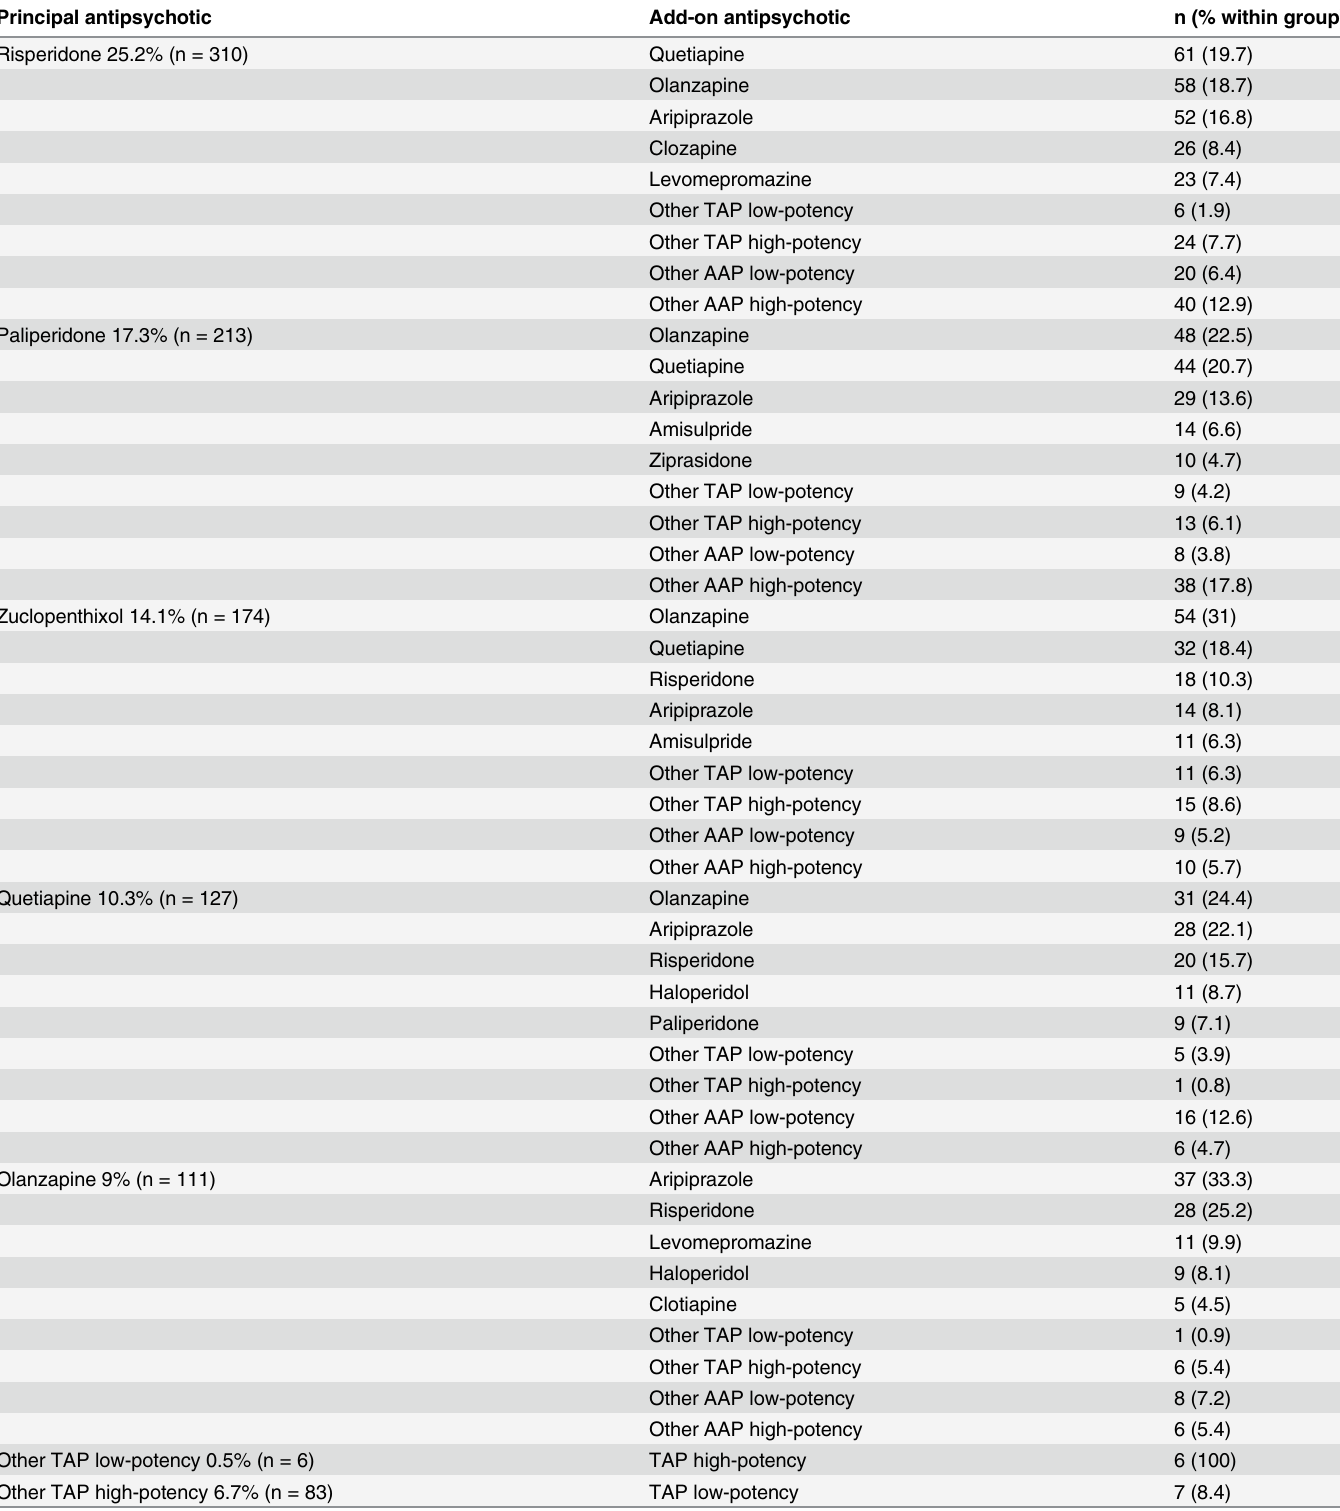
Table 3. Polypharmacy for the five most common principal antipsychotic